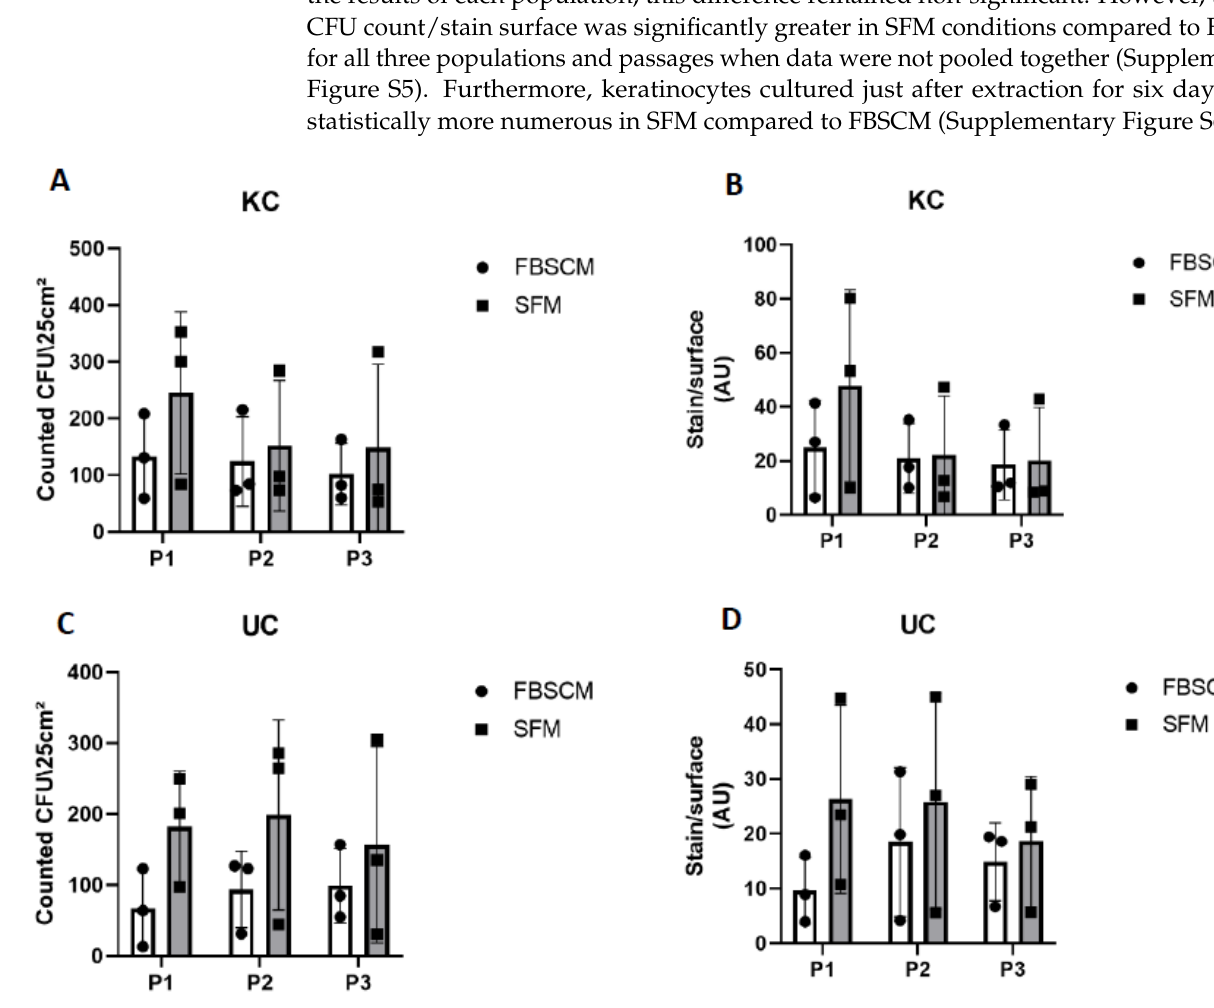
Figure 4. Clonogenicity evaluation of keratinocytes (KC) and urothelial cells (UC) over three passages. Clonogenicity was evaluated for KC by colony count (panel ( A )) or stained surface measurement (panel ( B )) and for UC by colony count (panel ( C )) or stained surface measurement (panel ( D )). Ordinary two-way ANOVA was used to interpret the data. Each dot represents the mean of a cellular population (N = 3) cultured in triplicate ( n = 3).